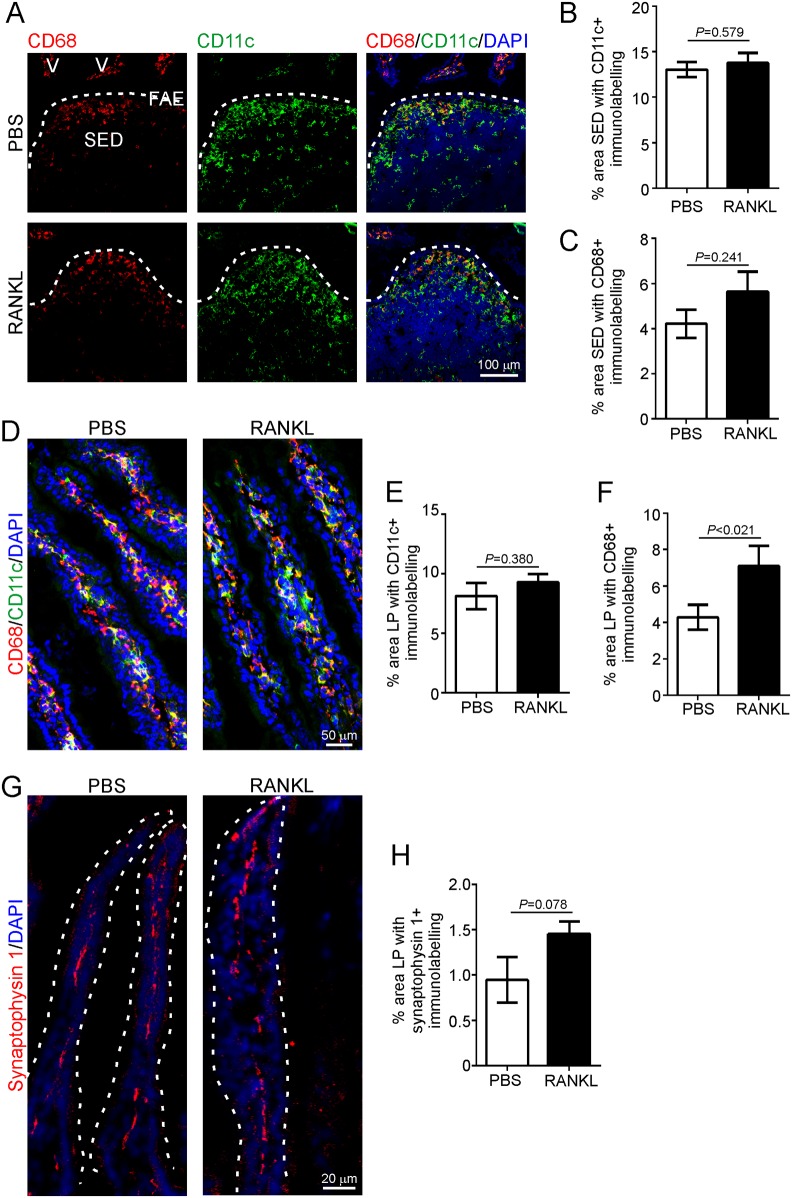
Effect of RANKL-treatment on mononuclear phagocytes and innervation in Peyer’s patches and the lamina propria of the intestine.C57BL/6 mice were treated daily with RANKL (or PBS as a control) to induce M cell-differentiation and Peyer’s patches and intestines collected on d 3. A) Immunohistochemical (IHC) comparison of the distribution of CD11c+ (green) and CD68+ (red) mononuclear phagocytes (indicative of classical DC and tissue macrophages, respectively) in Peyer’s patches of RANKL- and PBS-treated mice. Sections were counterstained with DAPI (blue) to detect cell nuclei. Broken lines show the lumenal boundary of the follicle associated epithelium (FAE). SED, subepithelial dome. Morphometric analysis suggested that the % area of the SED occupied by CD11c+ (B) and CD68+ (C) immunostaining was similar in Peyer’s patches from each group (CD11c, P = 0.579, Student’s t-test; CD68, P = 0.241, Mann-Whitney U test; 4–8 SED/mouse, n = 4 mice/group). D) IHC comparison of the distribution of CD11c+ (green) and CD68+ (red) mononuclear phagocytes in the lamina propria (LP) of RANKF/F and RANKΔIEC mice. Sections were counterstained with DAPI (blue). Morphometric analysis suggested that the % area of (E) CD11c+ immunostaining was similar in the LP of mice from each group (P = 0.380, Student’s t-test), whereas the % area of (F) CD68+ immunostaining was increased in the LP of RANKL-treated mice (P < 0.021. Mann-Whitney U test; data derived from 4 LP areas/mouse, n = 4 mice/group). G) Sections of intestines from RANKL- and PBS-treated mice were immunostained to identify synaptophysin 1 (red) to enable enteric innervation in the gut wall to be compared in each treatment group. Sections were counterstained with DAPI (blue). H) Morphometric analysis suggested that the % area of synaptophysin 1+ immunostaining within the LP was similar (P = 0.078, Student’s t-test; data derived from 2–4 LP areas/mouse, n = 4 mice/group).